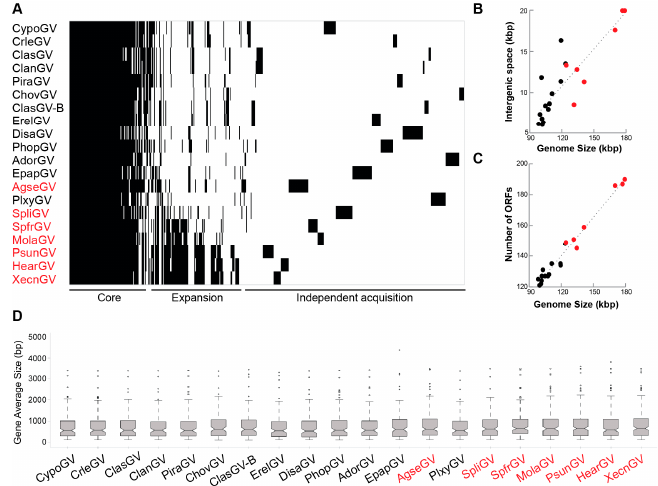
Figure 4. Genome expansion in the noctuid-infecting betabaculovirus lineage containing MolaGV. ( A ) A gene content matrix of selected betabaculoviruses. Black strips depict gene presence while white ones mean absence. Noctuid-infecting betabaculoviruses present a genome expansion (in red). The betabaculovirus core genes, the noctuid-infecting betabaculovirus-associated gene expansion and the independent acquisitions are indicated in the graph bottom; ( B ) Correlation between genome size and number of genes; ( C ) Correlation between genome size and intergenic spaces. Bigger the genome the more intergenic spaces exist and more genes are potentially codified for; ( D ) The gene size is maintained across Betabaculovirus . Highlighted in red, noctuid-isolated betabaculovirus species. Most of these expanded open reading frames (ORFs) correspond to the betabaculovirus clade a specific ORFs identified in XecnGV clusters 1, 2, 3 and 4 described by [38].